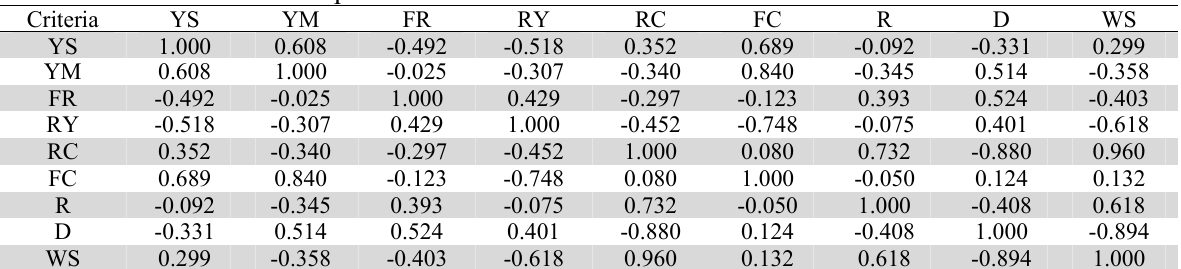
Correlation matrix for Example 2 Criteria YS